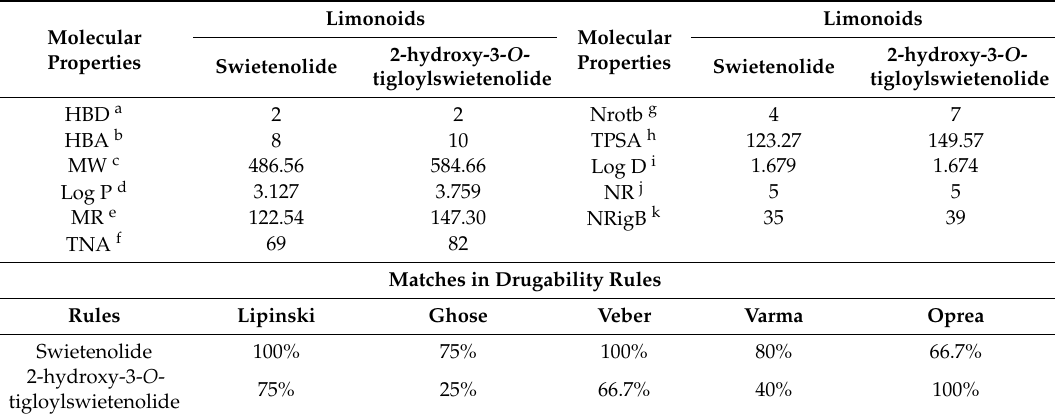
Table 1. Calculated physicochemical properties of the naturally-occurring limonoids swietenolide and 2-hydroxy-3- O -tigloylswietenolide by ADMETlab [28].